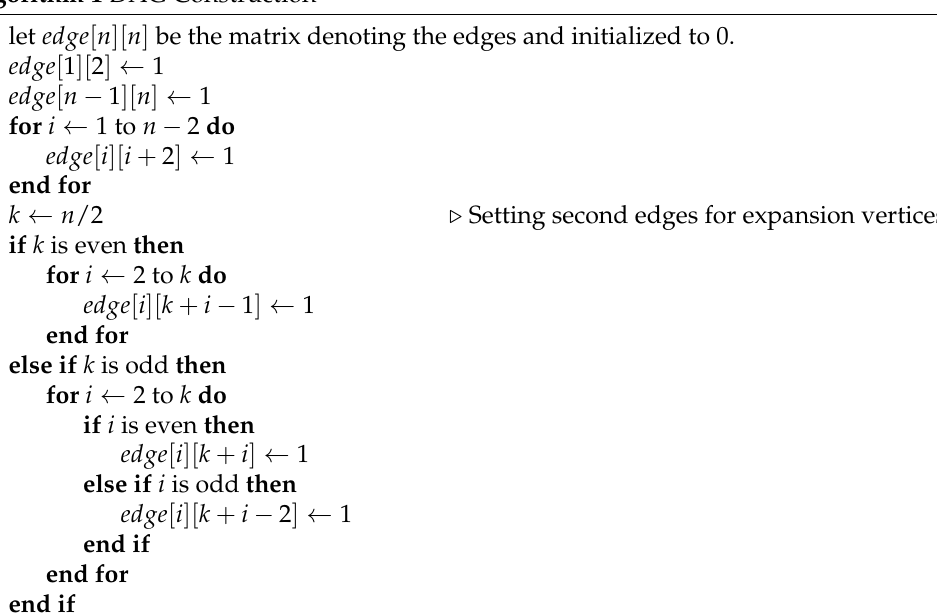
Algorithm 1 DAG